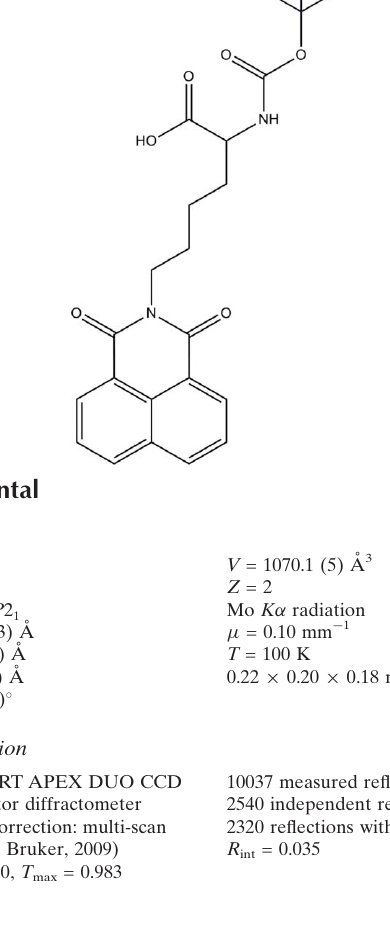
Data collection